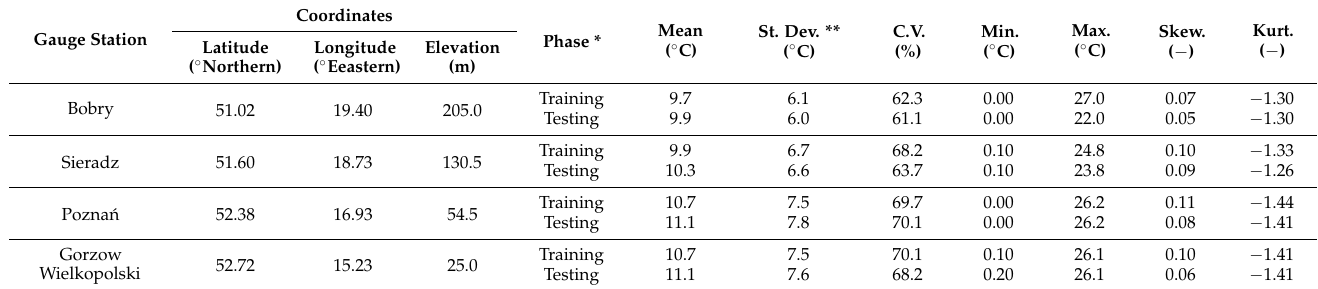
Table 1. The stations’ coordinate data and the specifications of the data under